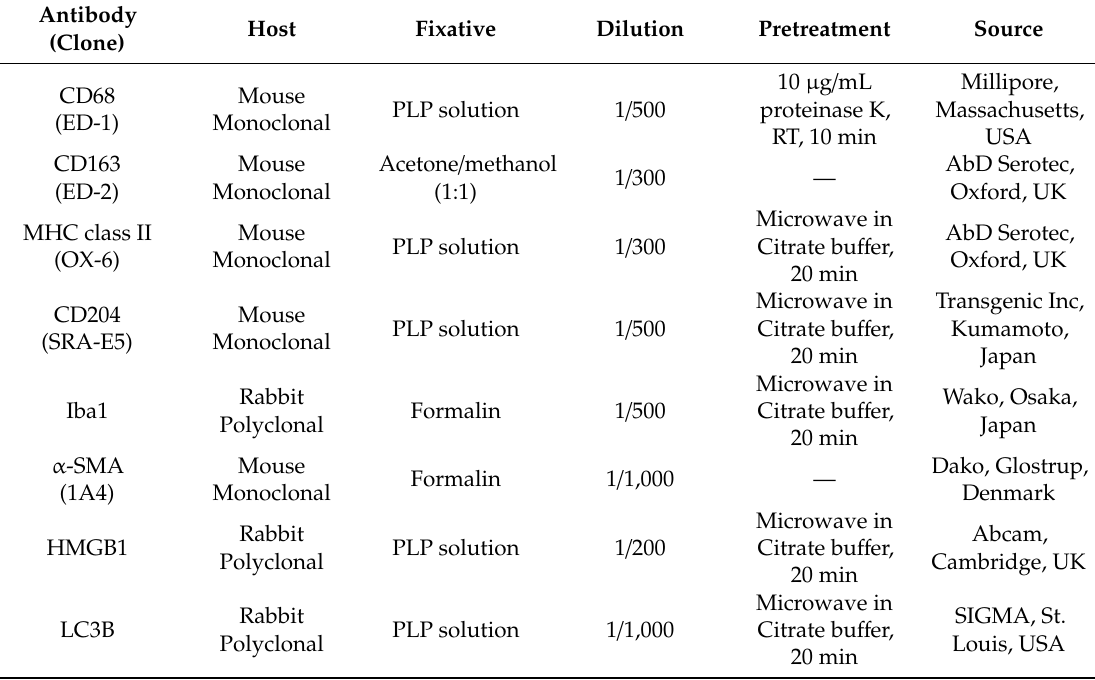
Table 2. Primary antibodies used in